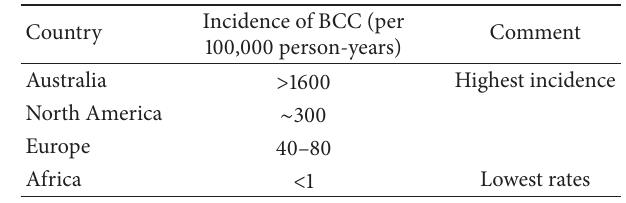
Table 7: Histopathological variants of BCC. Table 8: Worldwide incidence of